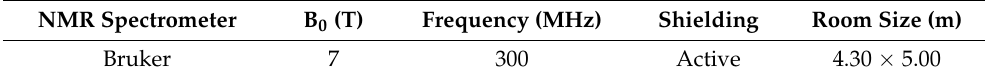
Table 1. Spectrometer